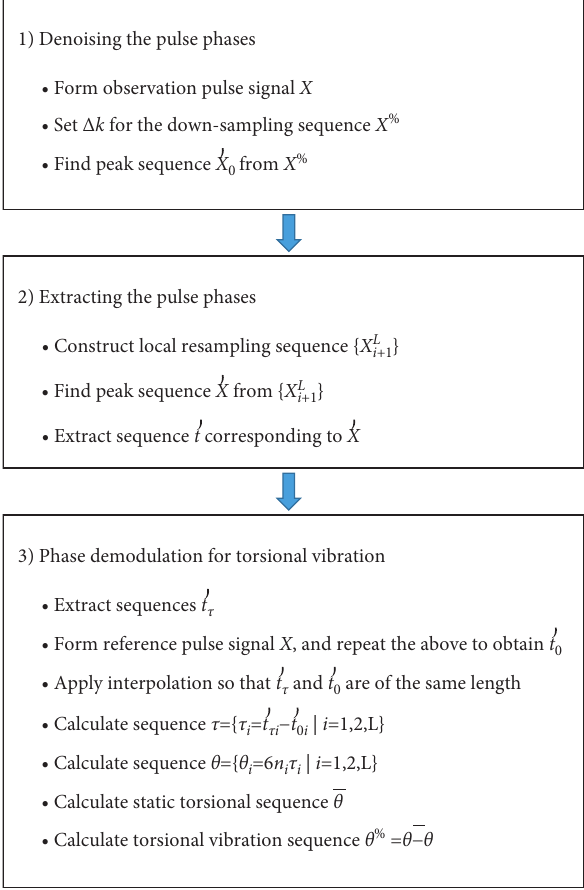
Figure 7: Flowchart of phase demodulation algorithm.